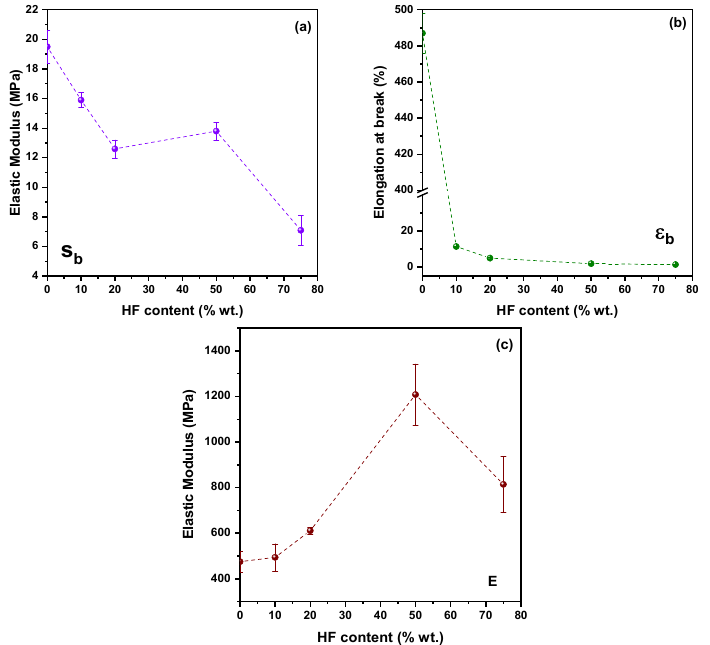
Figure 13. Effect of HF content on the ( a ) tensile stress at break, ( b ) elongation at break, and ( c ) elastic modulus of r-HDPE + HF + polyethylene-grafted maleic anhydride (PE-g-MA) composite materials. The lines are drawn to guide the eye.